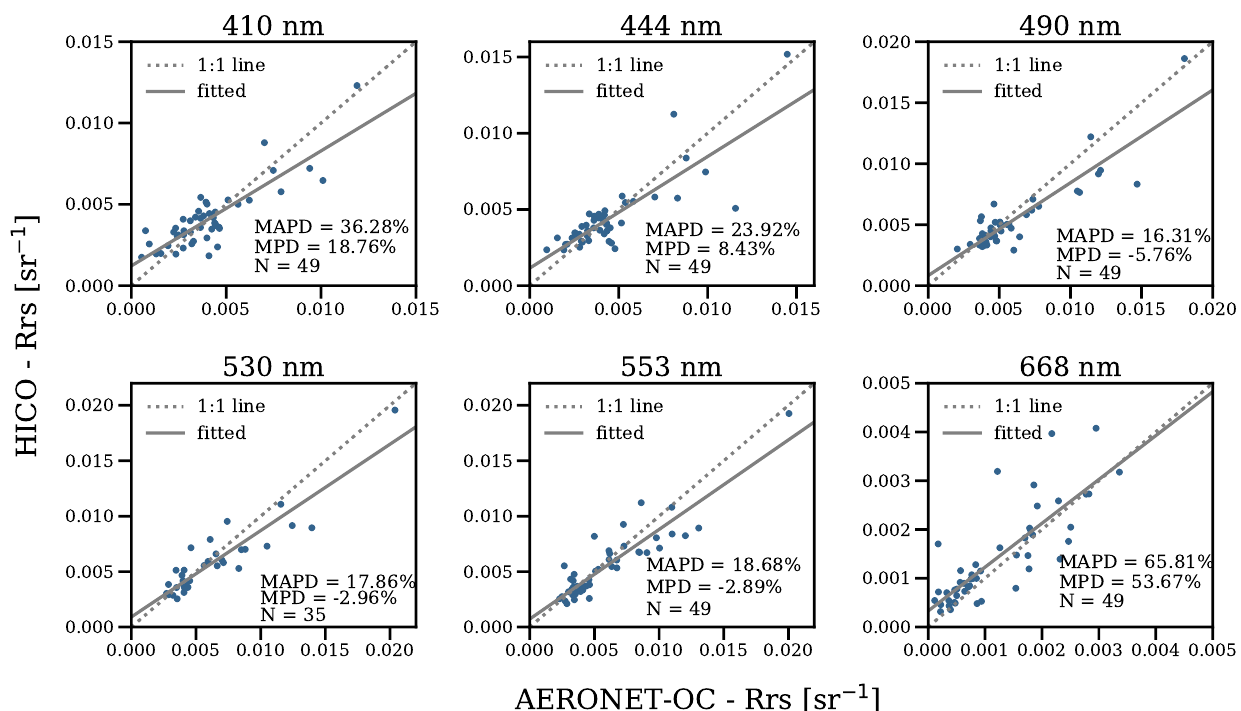
Figure 3. Scatterplots of the AERONET-OC Rrs versus Polymer-HICO Rrs. The two match-ups with both flags ‘case-2’ and ‘inconsistency’ raised were excluded before the statistics were